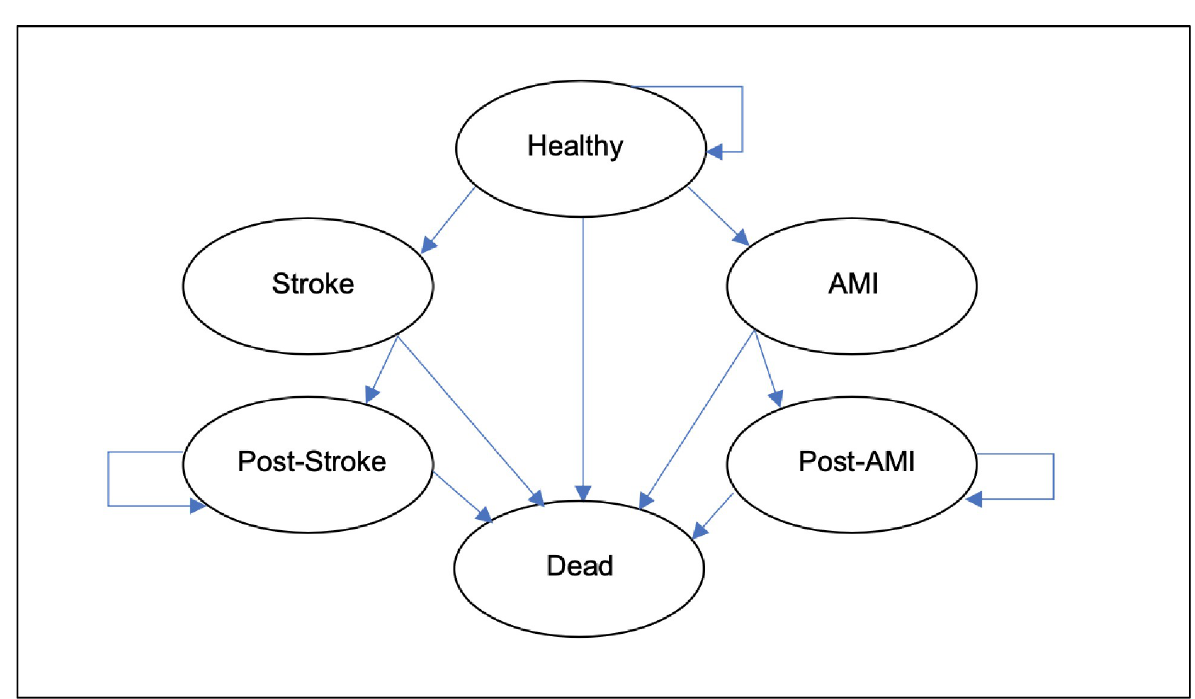
Fig 1. Markov model